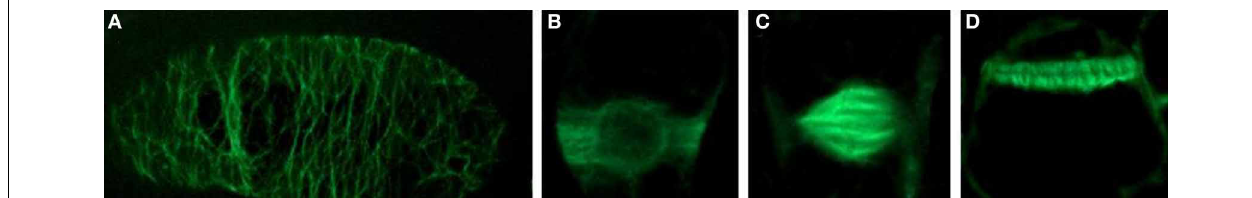
FIGURE 3 | Localization of 3-NO 2 -Tyr in interphase and mitotic microtubules of intact N. tabacum (BY-2) cells revealed by FITC-anti- α -tubulin (TU-01) and TRITC-anti-3-NO 2 -Tyr. (a) TU-01 (green